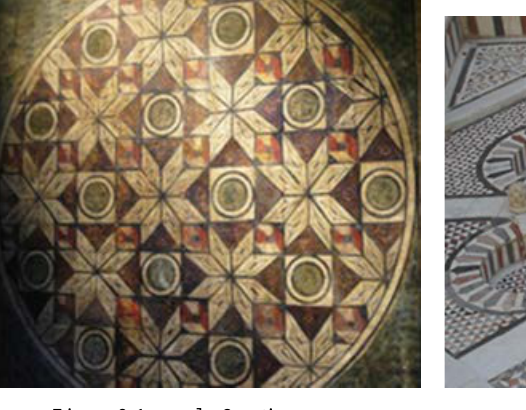
Figure 6-1 panels, Coptic museum Figure 6-2 water fountain, marble work, Coptic Museum